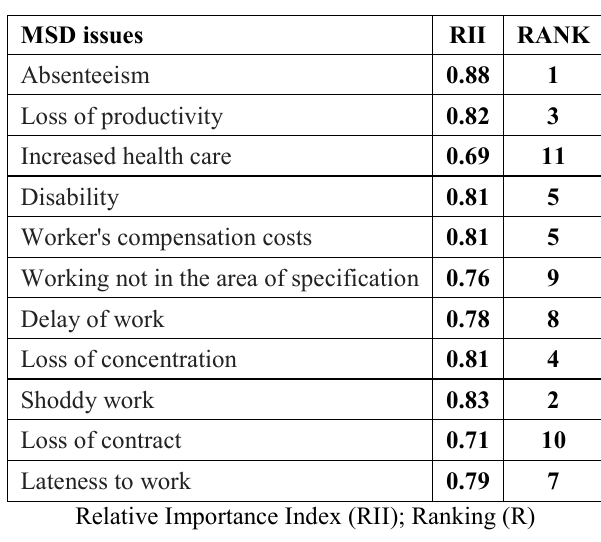
Table 4. Effect of